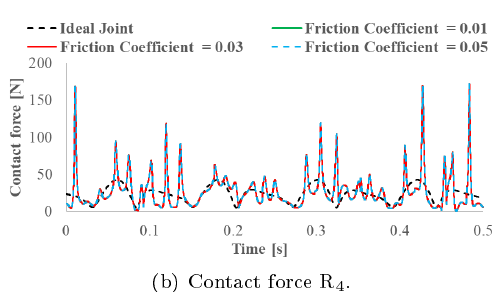
Fig. 14: Contact force R 7 at di(cid:27)erent friction coe(cid:30)- cient.